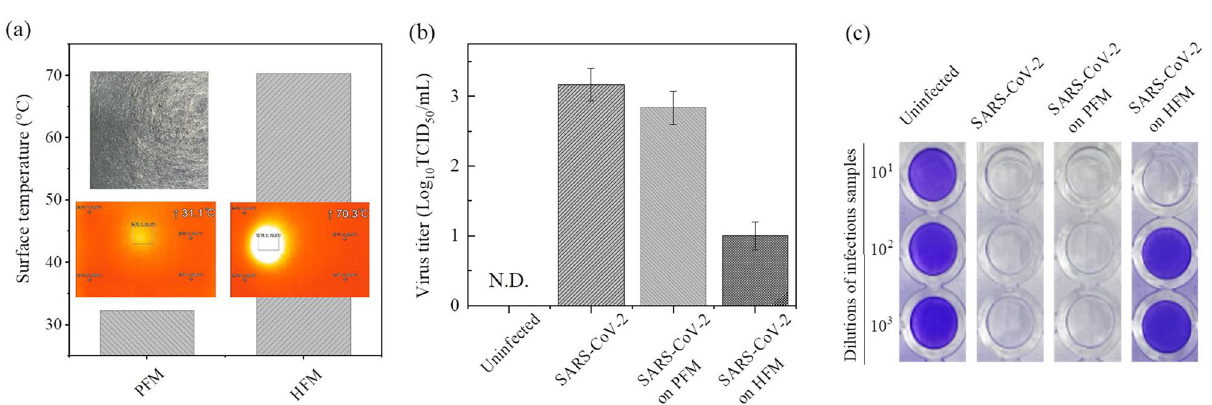
Figure 4. Assessment of the titer of the H1N1pdm09 virus with respect to the PTI time. ( a ) Schematic view of the PTI kit. ( b ) Result of the TCID 50 assay with respect to the PTI time and natural inactivation. ( c ) Photographs of the crystal violet staining of the MDCK cells with respect to the PTI time.